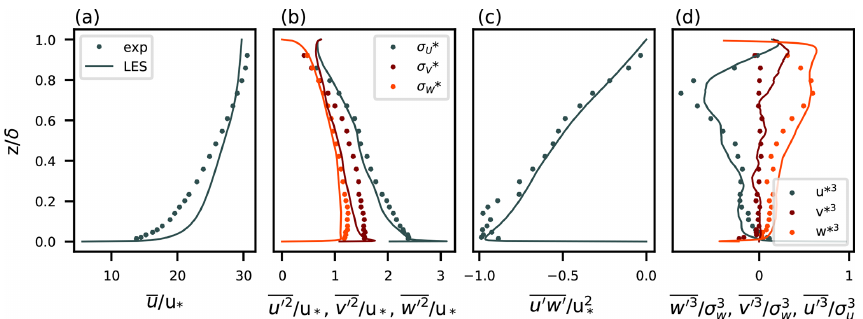
Figure 2. Vertical profiles of non-dimensional velocity statistics and comparison with the Nironi et al. (2015) data. (a) Mean longitudinal wind speed. (b) Variances of three wind components. (c) Reynolds stress. (d) Triplet